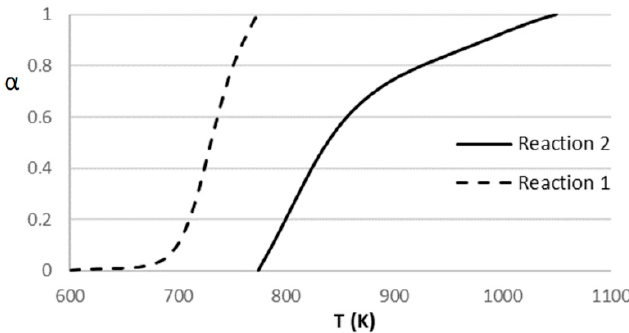
Figure 5. Degree of conversion vs. T for each defined reaction.